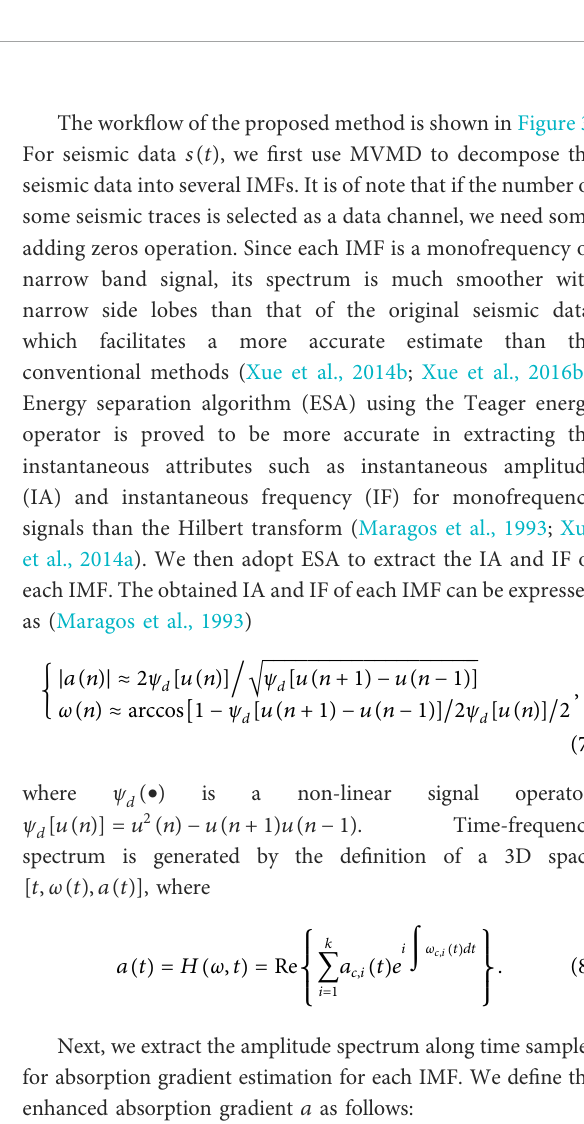
FIGURE 3 Work fl ow of the proposed